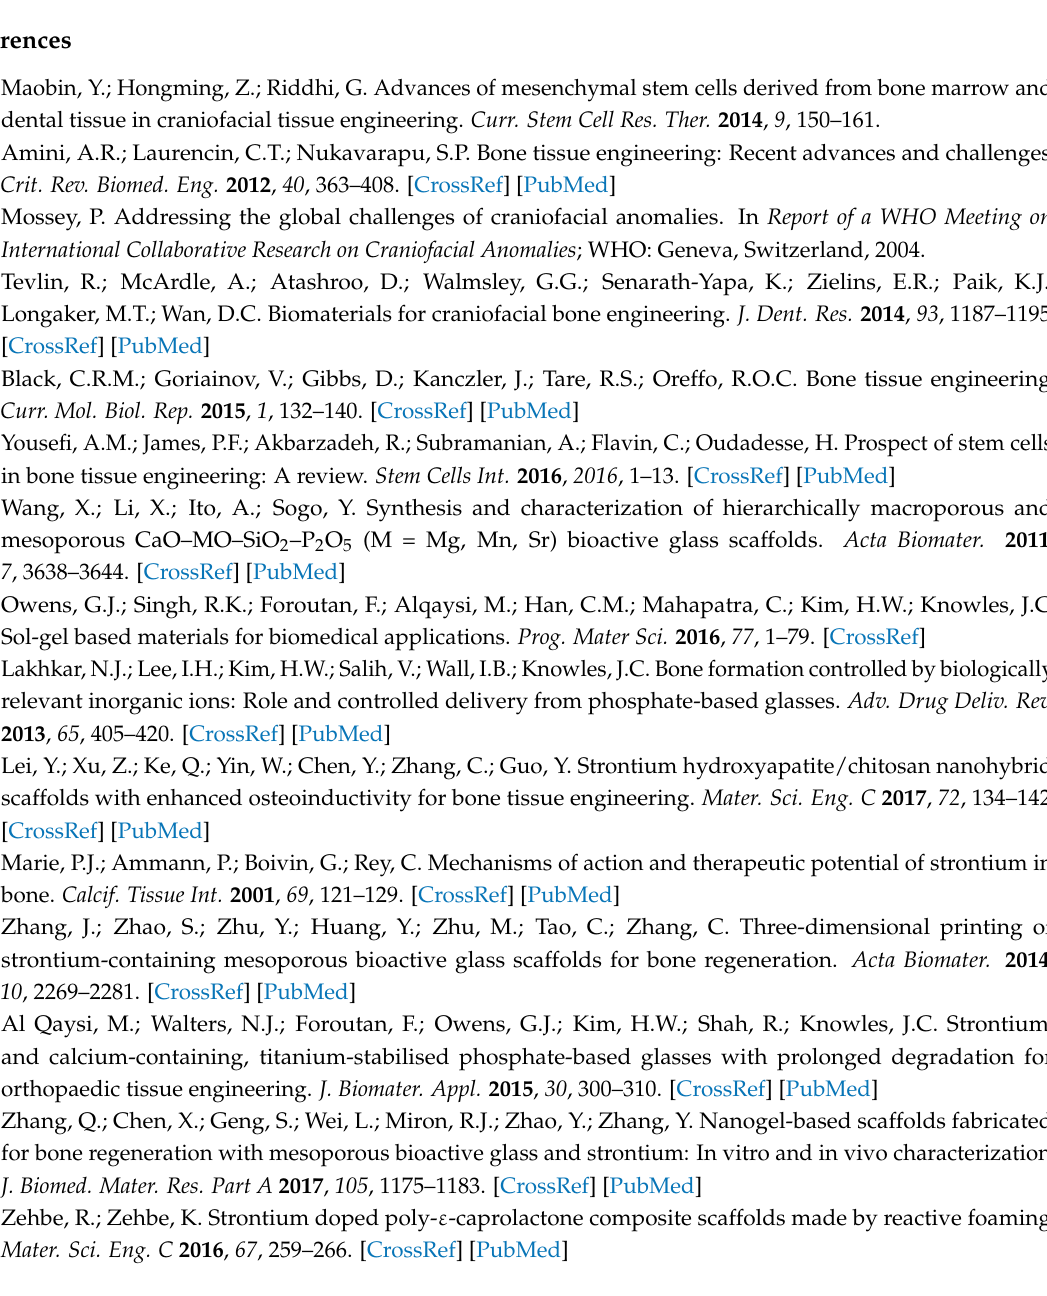
Figure S3: SEM images of Sr(II) membranes after 30 d immersion in PBS buffer at 37 ◦ C. a) 200x; b) 500x; c) 1000x, Figure S4: In vitro cytotoxicity results of blank and Sr(II) membranes using MG-63 cells (a) and hBMSCs (b). Results are given as mean ± sd ( n = 5), Table S1: DTG (Derivative Thermogravimetric analysis) results of pure PCL (poly( ε -caprolactone), chitosan (Ch), blank and Sr(II)